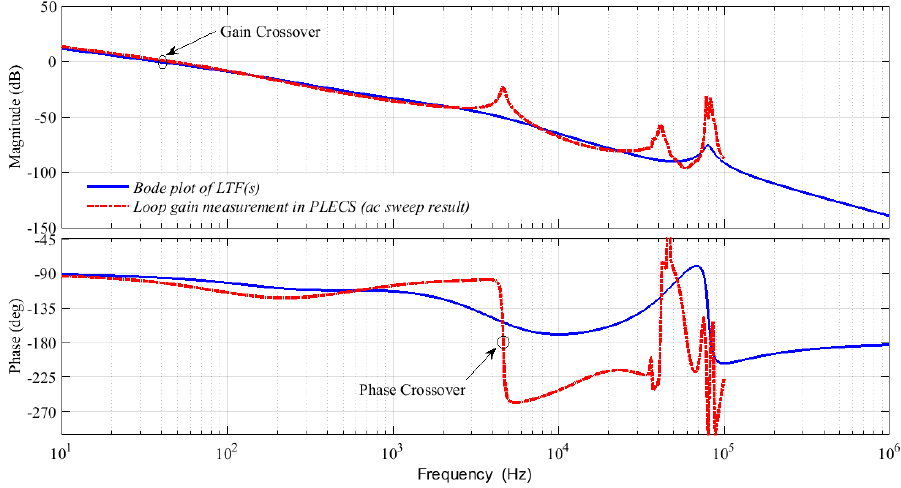
Figure 7. Bode plots for loop transfer function.